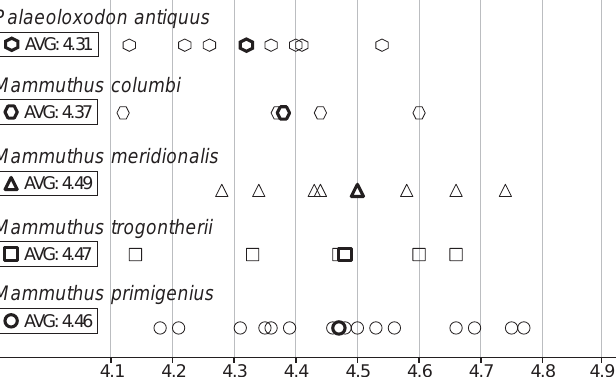
Fig. 8. Fibula length vs. skeletal shoulder height ratio of selected probos- cideans based on the data collected in this study (Appendix 1, SOM: table 2; AL unpublished